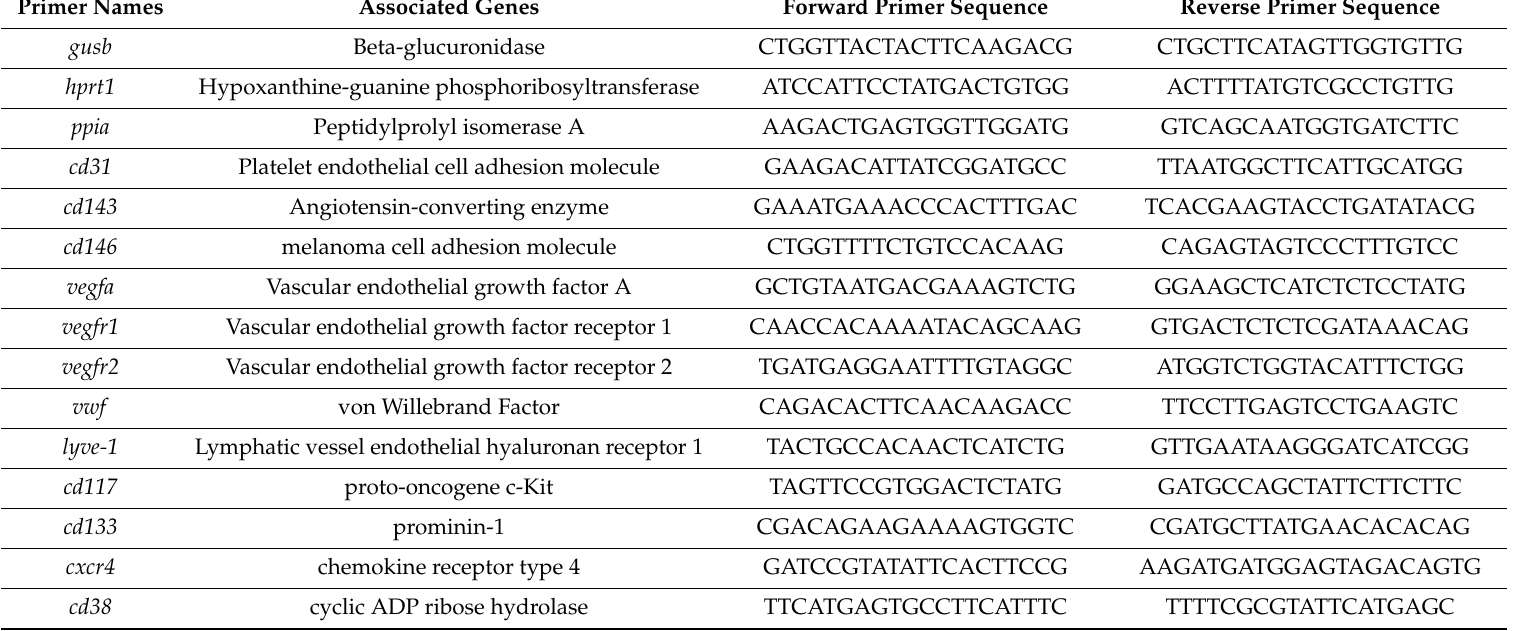
Table 5. Bovine genes and associated primers used for the cell lines characterization by